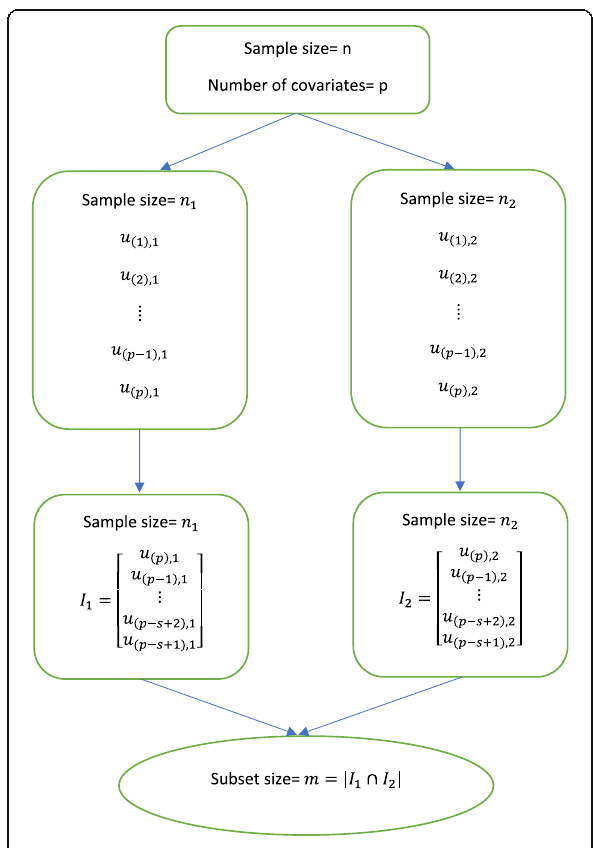
Fig. 2 Process of the aggressive variant of sure independence screening